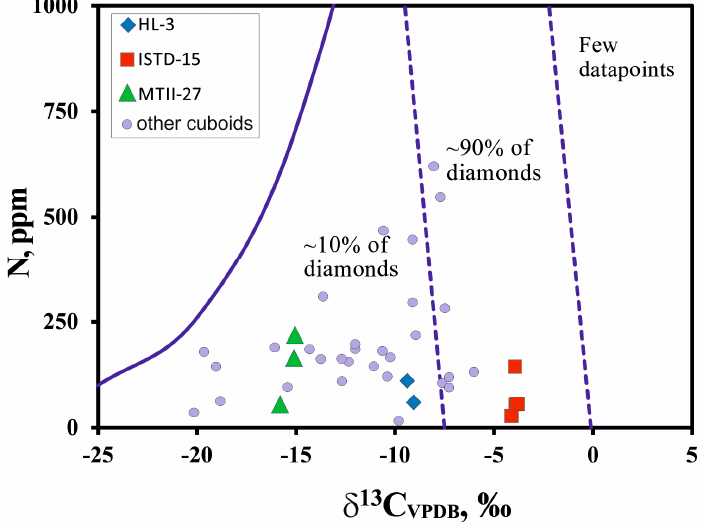
Figure 2. Carbon isotope values ( δ 13 C VPDB ) and nitrogen abundance (N, ppm) in yellow cuboid diamonds from alluvial placers in the northeastern Siberian platform compared to worldwide data summarized by Cartigny et al., 2001 [17].